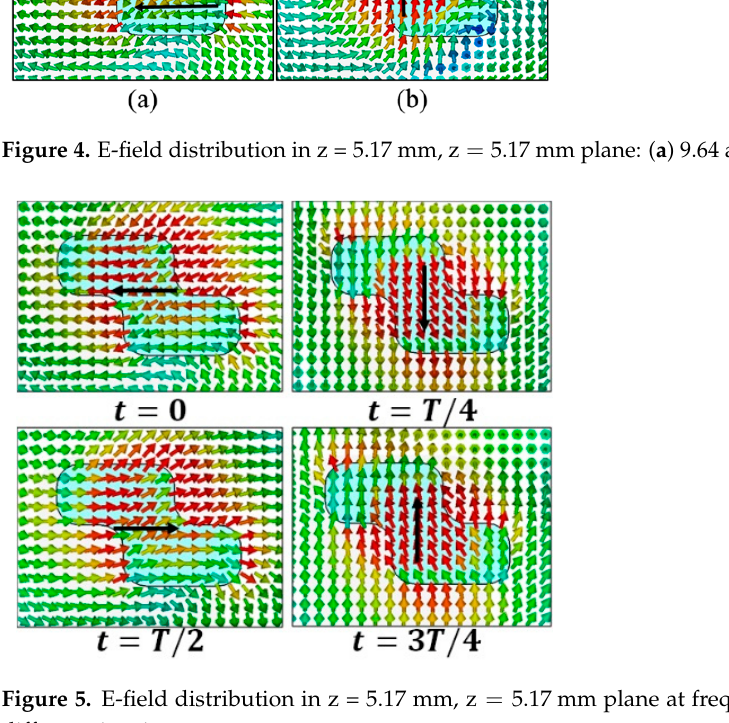
Figure 5. E-field distribution in z = 5.17 mm, z = 5.17 mm plane at frequency of 9.77 GHz at the different time instants.